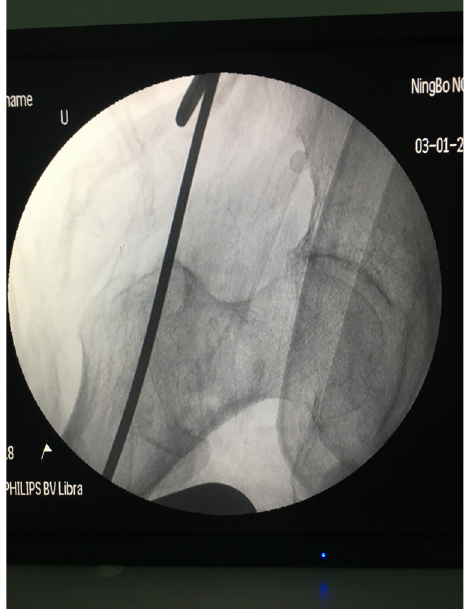
Figure 1. After reduction of intertrochanteric fracture, a guide pin was inserted into tip of the trochanter.